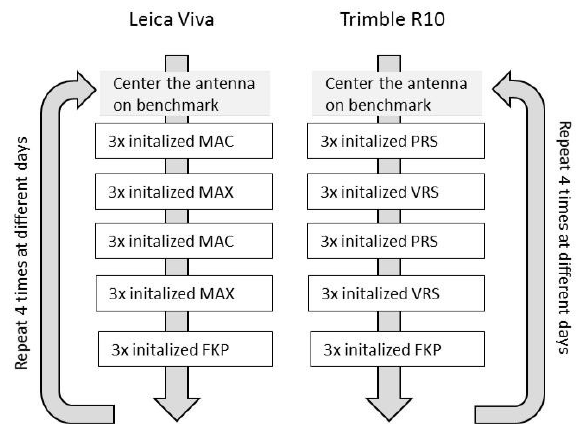
Figure 5: Test procedure at all the test points for fully operational (interpolation) networks. With Leica Viva receiver MAC, MAX and FKP corrections and with Trimble R10 PRS, VRS and FKP corrections were used. MAC, PRS and FKP corrections came from NLS service, MAX from SmartNet and VRS from Trimnet.